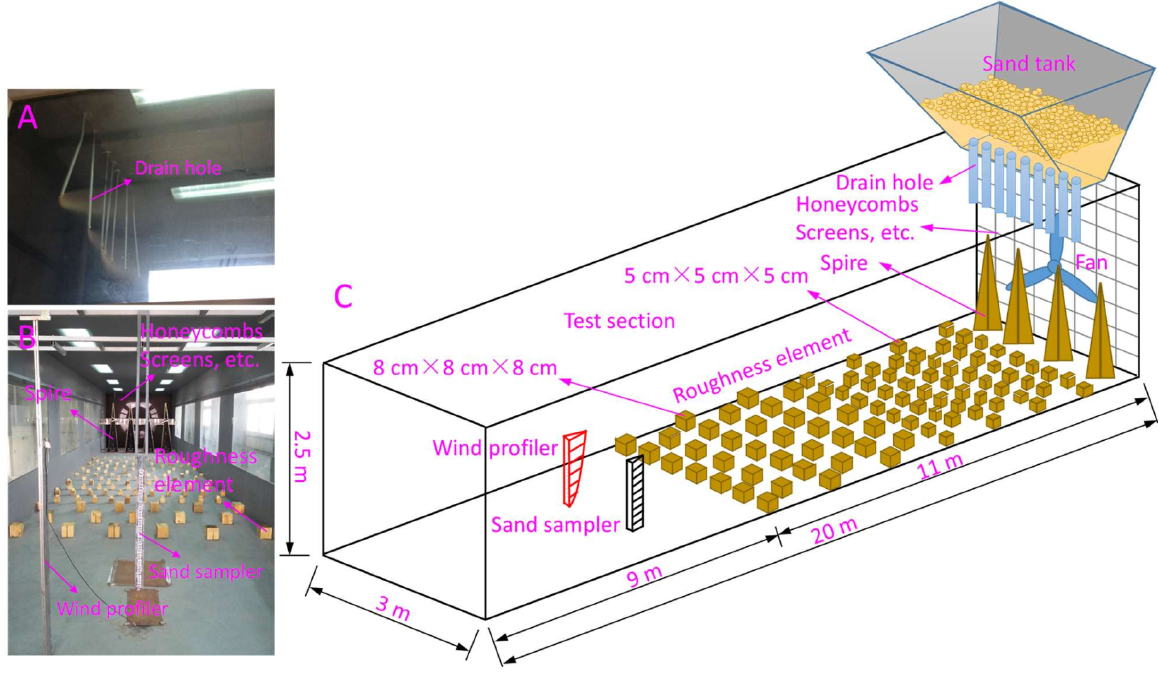
Figure 1. Instruments and flow field arrangement in the wind tunnel: ( A ) Drain hole; ( B ) Wind profiler and sand sampler; ( C ) Flow field